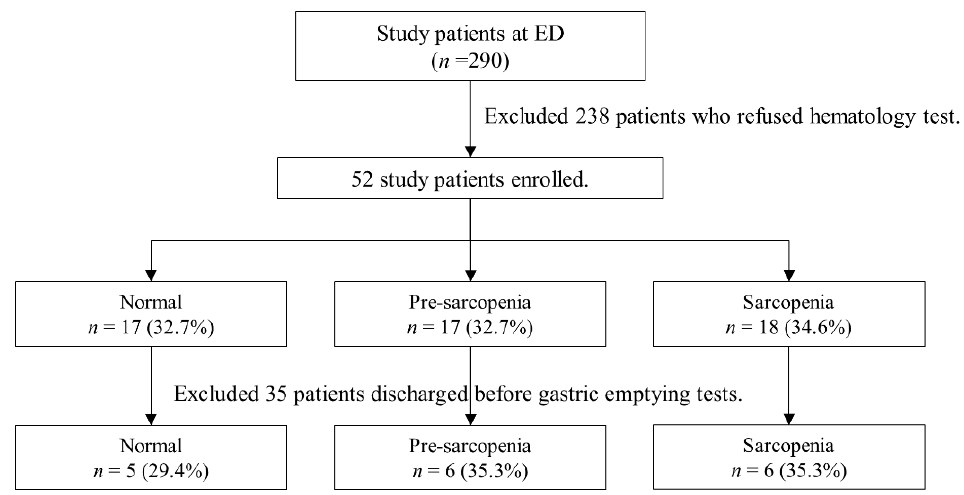
Figure 1. Flow diagram of the study. Table 1. Baseline demographic characteristics, variables of clinical assessment, and comprehensive geriatric assessment of older patients between groups.